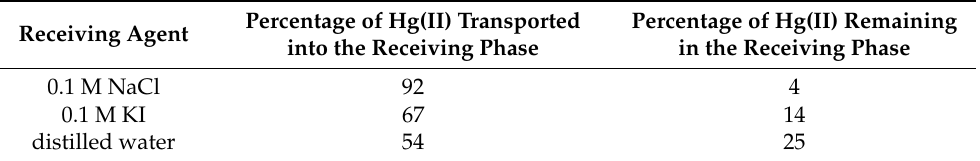
Table 3. Effect of the nature of the receiving phase on the transport of Hg(II) ions across PIMs. Source